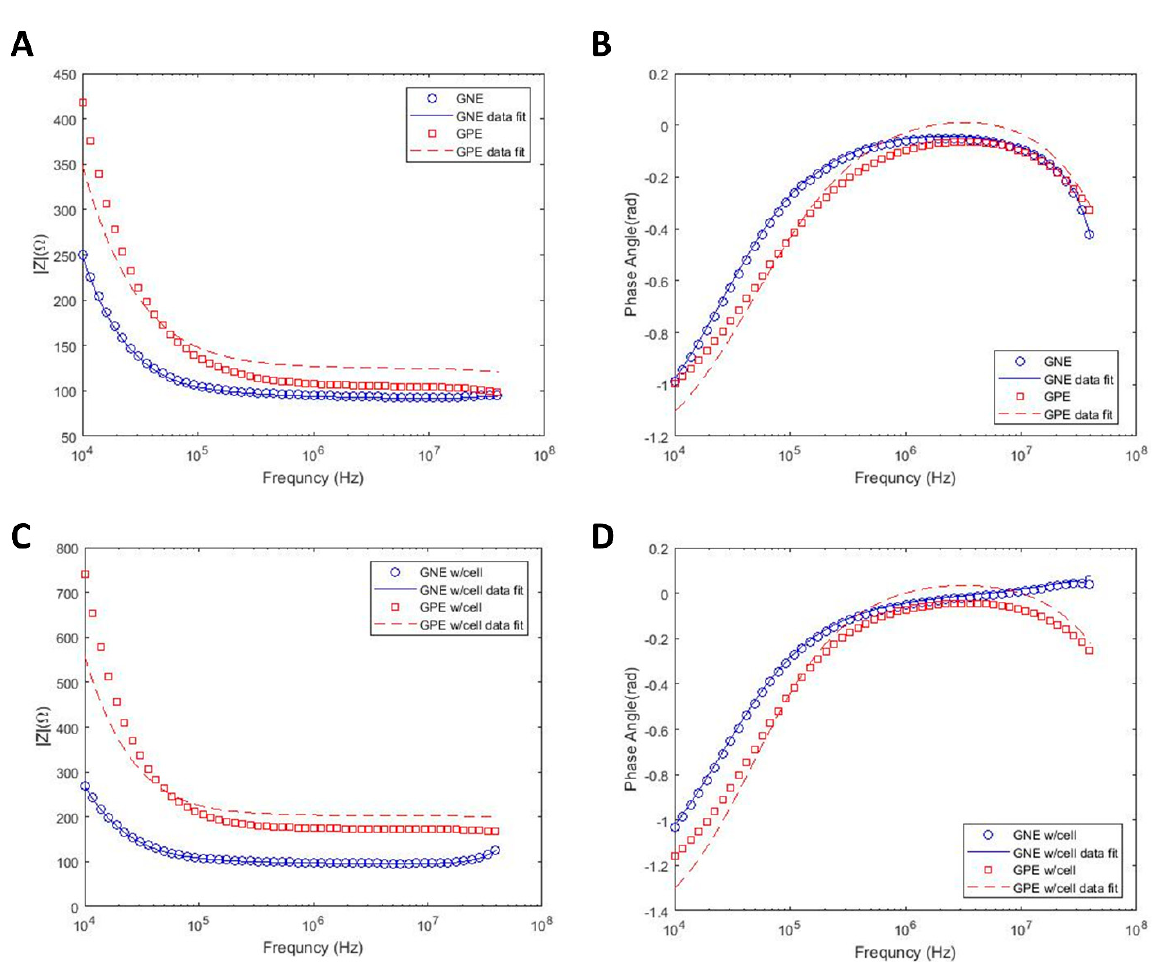
Figure 2. Impedance magnitude and phase angle spectra of GPE and GNE as a function of the frequency in growth media (RPMI-1640) with σ = 1.5 S/m and curve fit with equivalent circuit model. Impedance spectra in growth media only ( A , B ) and in growth media with suspended PC3 cells ( C , D ). Table 2. Effect of channel width and nanostructure on the extracted